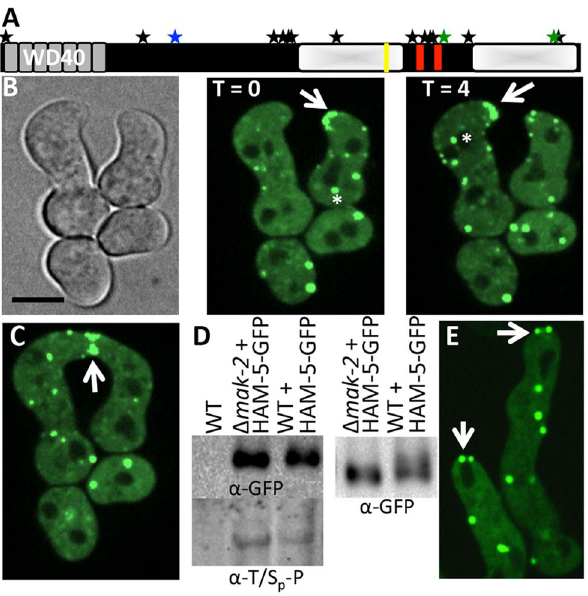
Figure 2. HAM-5-GFP localization in WT and D mak-2 germlings. (A) Schematic overview of HAM-5 protein structure. The predicted WD40 domains are shown in grey and the putative coiled coil domains are shown as red bars. The two disordered regions with low complexity are depicted by shaded white boxes. The MAPK phosphorylation site (aa 506) is marked by a blue star, the other two sites showing decreased abundance in treated cells (aa 1288 and 1604) are marked by green stars, and other 13 identified phosphorylation sites (S14, S414, S792, S818, S833, T838, T969, S1085, S1199, T1201, S1202, T1353, S1608) [40] are marked by black stars. The putative MAPK docking site is marked by a yellow line. (B) Localization of HAM-5-GFP to puncta localized to CAT tips during chemotropic interactions between genetically identical cells. HAM-5-GFP showed dynamic localization to CAT tips of germlings with an oscillation of every four min (arrow). HAM-5-GFP also localized to puncta within germlings and near nuclear compartments devoid of HAM-5-GFP (asterisks). The image left is a bright field image. Scale bar =10 m M. (C) HAM-5-GFP localized to the sites of contact during germling fusion (arrow). (D) Western blots of WT, WT ( ham-5-gfp ) and D mak-2 ( ham-5-gfp ) germlings with immunoprecipitated HAM-5-GFP probed with anti-GFP antibodies (right panel shows longer run showing higher mobility of HAM-5-GFP in wild type germlings) specifically detecting HAM-5-GFP (210 kD; Figure S4D). Lower panel shows a Western blot with identical samples probed with anti-phospho antibodies that specifically detect phosphorylated serine or threonine residues followed by a proline. (E) Localization of HAM-5-GFP to puncta in D mak-2 germlings. Some puncta showed localization to germling tips, but which did not oscillate during growth (white arrows). Scale bar =10 m